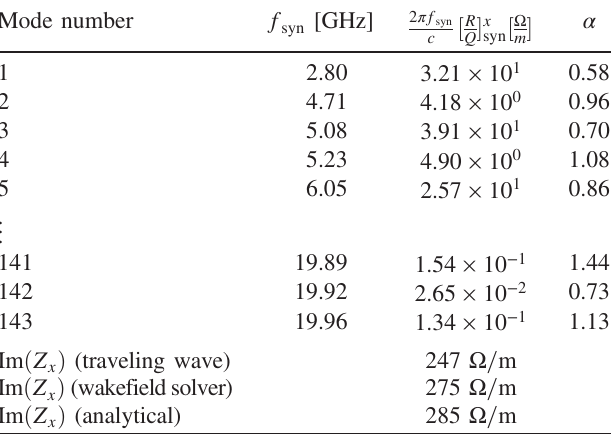
TABLE IV. Transverse traveling wave data for one period of the circular pipe structure depicted in Fig. 5. The final result for Þ is the sum of the elements of the third column weighted Im ð Z x with the corresponding factors α . The results of the wakefield solver and the analytical formula are also shown for